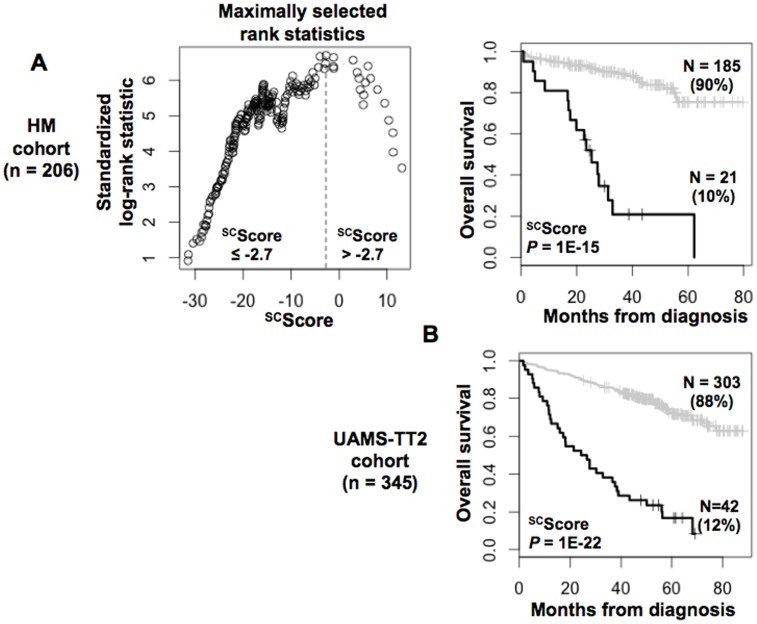
Building a myeloma-stem cell score (SCscore) for predicting overall survival.A. The prognostic information provided by the 37 stem cell myeloma genes was summed within a SCscore as defined in the Materials and Methods. Patients of HM cohort were ranked according to increased SCscore and a maximum difference in OS was obtained with SCscore  = −2.7 splitting patients in a high risk (10%) and low risk (90%) groups. B. Validation of SCscore using UAMS-TT2 cohort.